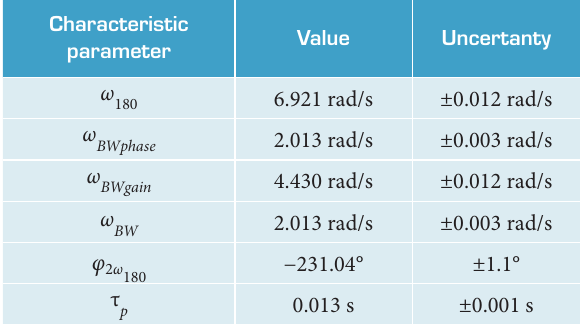
Figure 13. Definitions of ω